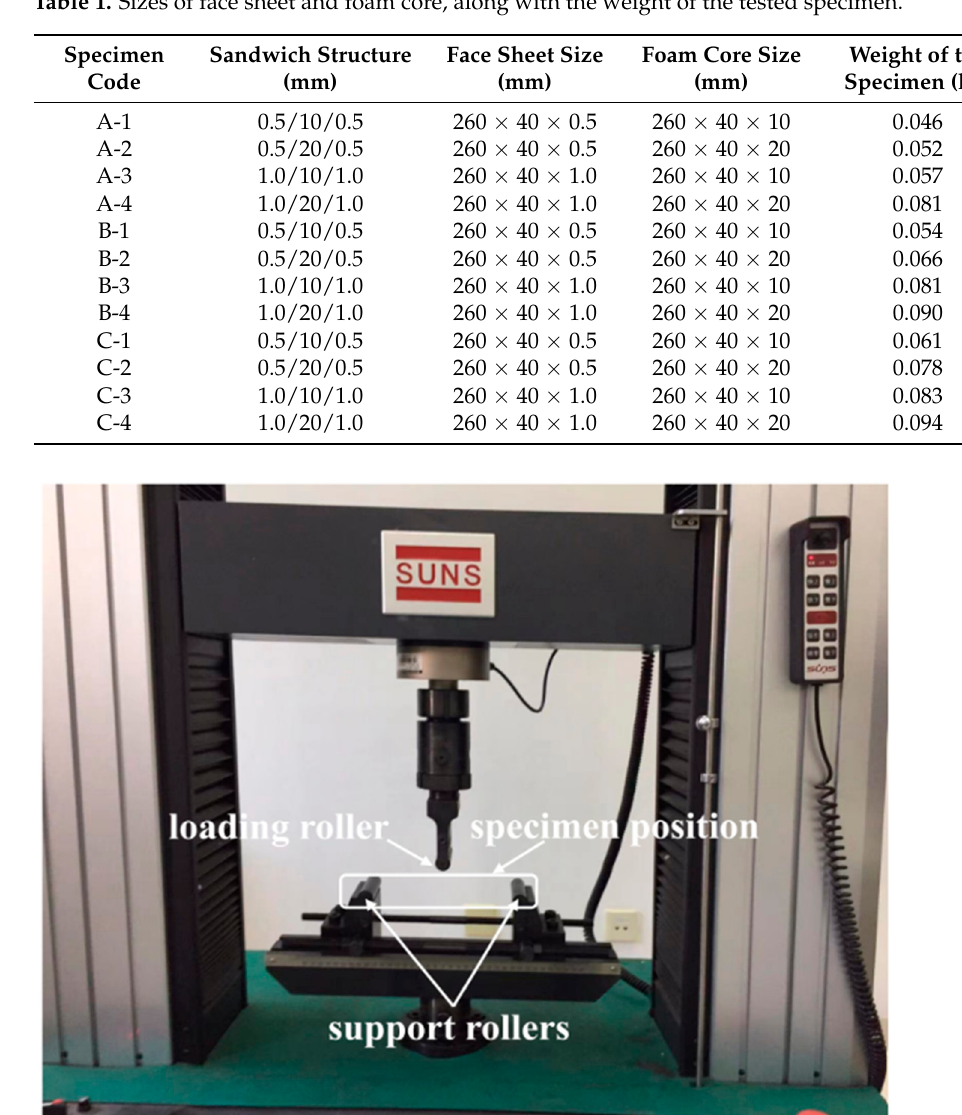
Figure 1. Experimental apparatus for the three-point bending test. For the impact tests, a revised split-Hopkinson pressure bar was used to perform the impact tests, as shown in Figure 2. A steel striker bar was launched by a gas gun to strike the clamped sandwich beam in its mid-span. The mass of the striker bar was 8 kg, and the dimensions of the striker bar were: 40 mm in diameter and 800 mm in length. The sandwich beam was clamped on a fixed frame, and the effective span of the sandwich beam was 200 mm. The impact velocity of the striker bar was measured by a laser velocimeter. Additionally, a 352C04 PCB accelerometer sensor (PCB company, Depew, NY, USA) was fixed to the striker bar, and it was used to measure the de-acceleration of the striker bar, as shown in Figure 2. The signal of the accelerometer was amplified by the signal conditioner of a PCB 482C05 (PCB company, Depew, NY, USA), and then the signals were recorded using a Tektronix MDO3034 oscilloscope (Tektronix, Beaverton, OR, USA). The data-sampling rate was 5 MHz. The sensitivity of the accelerometer was 9.89